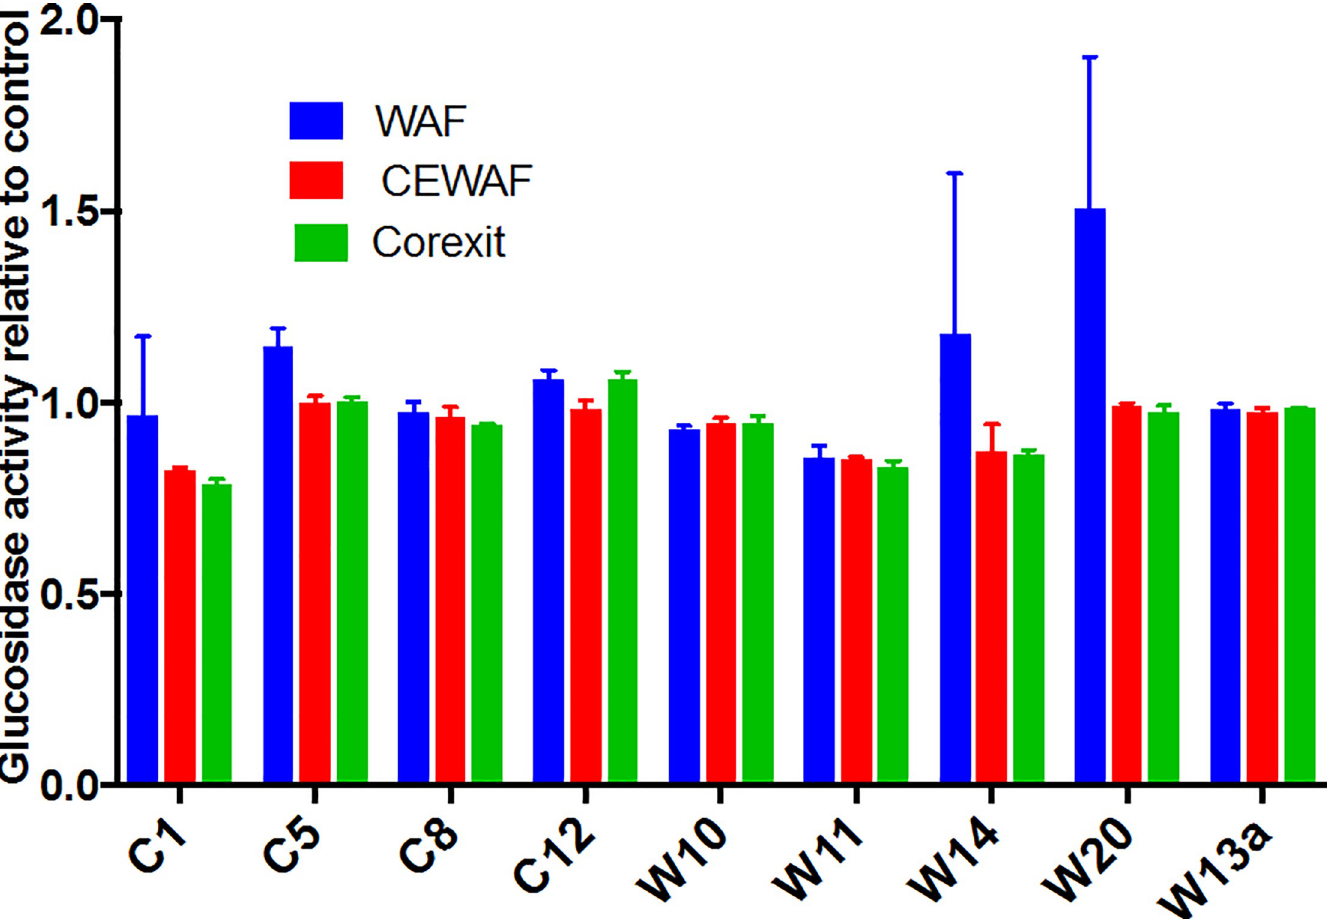
Fig 6. Glucosidase activity in WAF, CEWAF and Corexit after 4 d of incubation with the nine bacterial isolates. The values are ratios relative to Control. Error bars represent the standard deviation of the replicates. There was no significant difference among the treatments (P > 0.05).